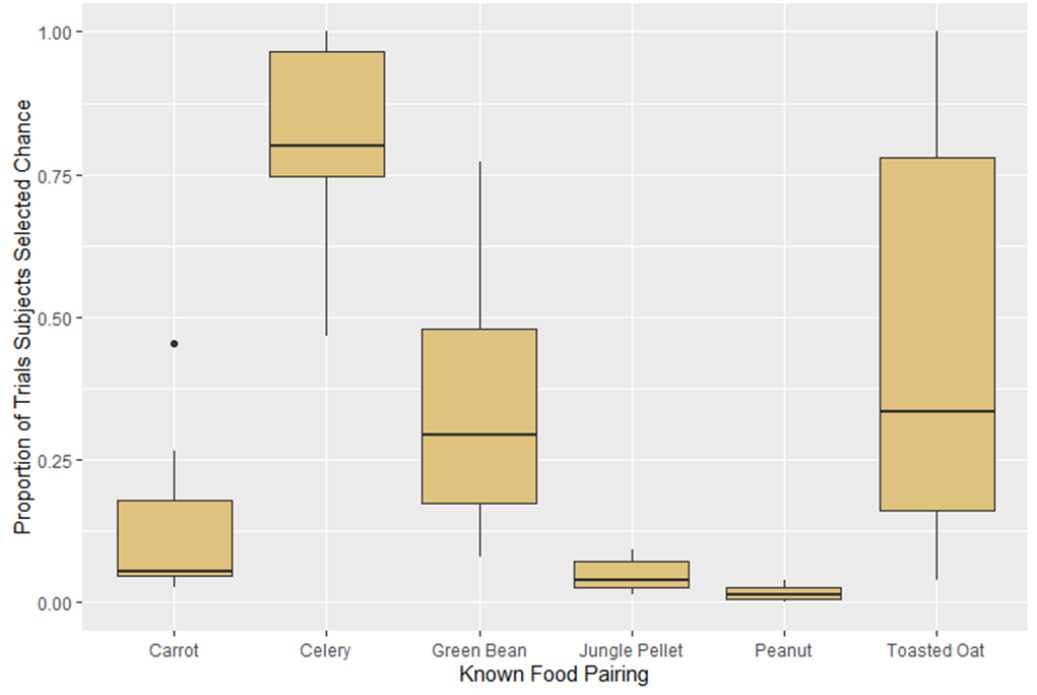
The Average Proportion of Trials Japanese Macaque Subjects Selected the Chance Symbol over the Known Food